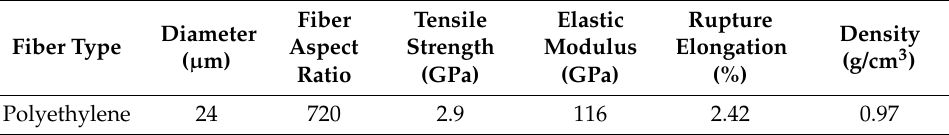
Table 3. Properties of polyethylene (PE) fiber as provided by